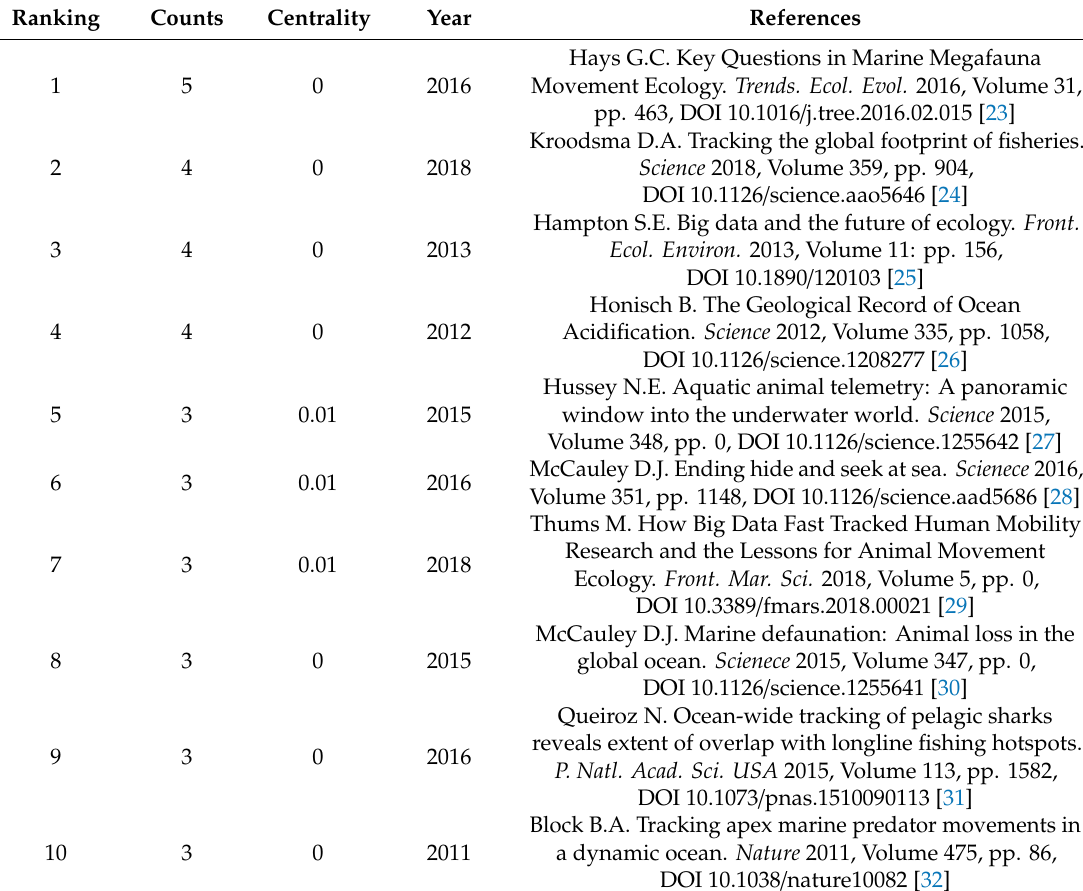
Table 6. Top 10 most cited references of big ocean data